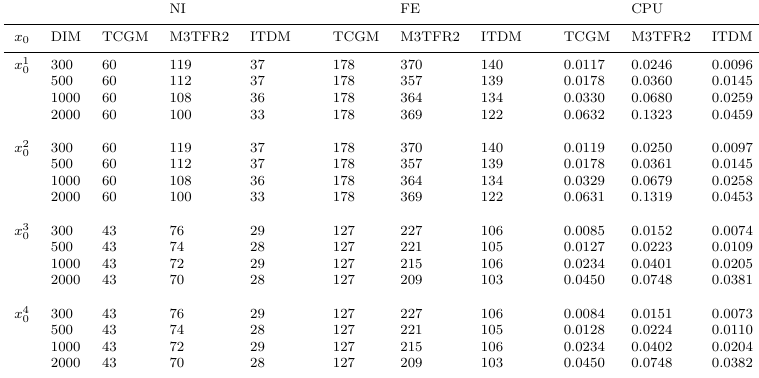
Table 7. Numerical results of Problem 7.